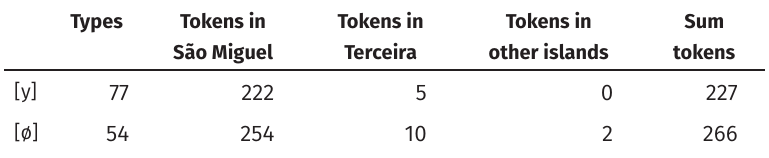
Table 1: Composition of the data